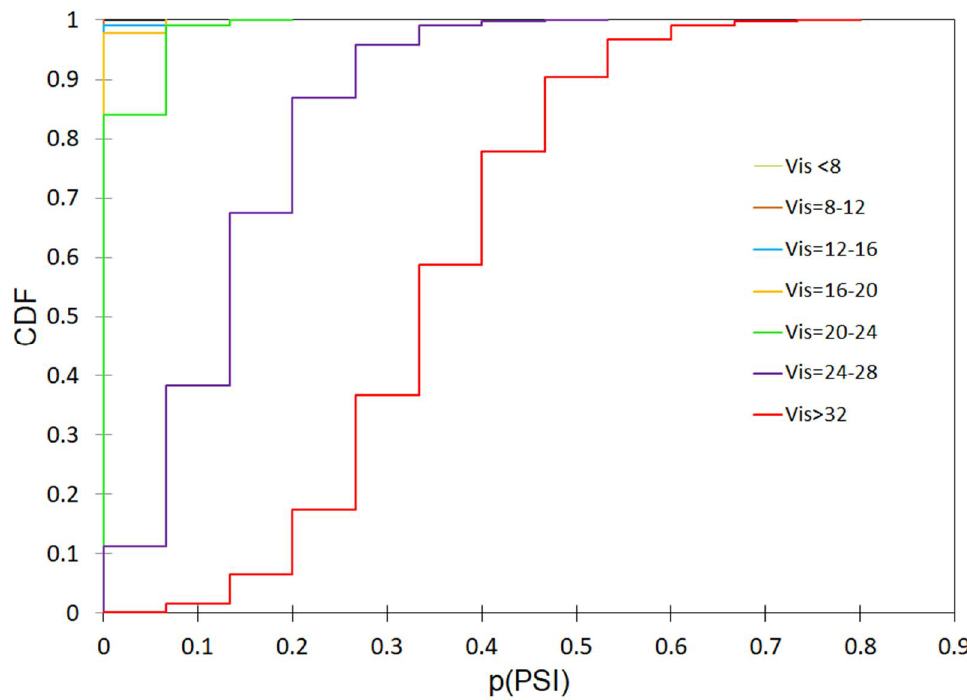
Figure A20. Effect of visibility on the incidence of low summer mortality for rainy days.